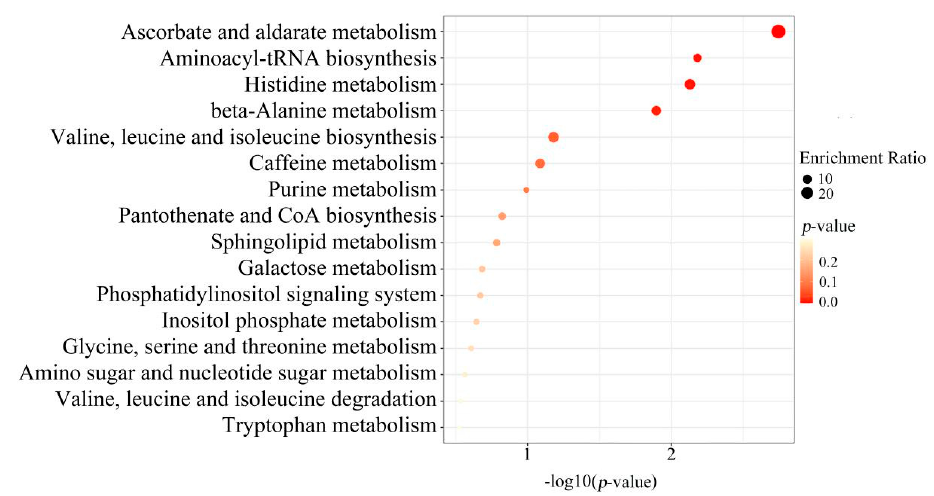
Figure 9. KEGG pathway analysis: enrichment of metabolites with a significant difference between Wild, Cultivated I and Cultivated II.